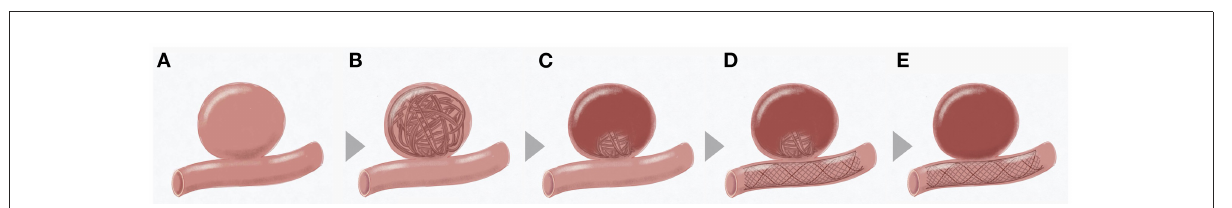
FIGURE1 Flow chart of coiling followed by staged flow diversion for unruptured intracranial aneurysms. (A) Sketch of an intracranial aneurysm; (B) First-stage coiling; (C) Thrombosis formation induced by coiling; (D) Second-stage flow diversion; (E) Complete occlusion after flow diversion.